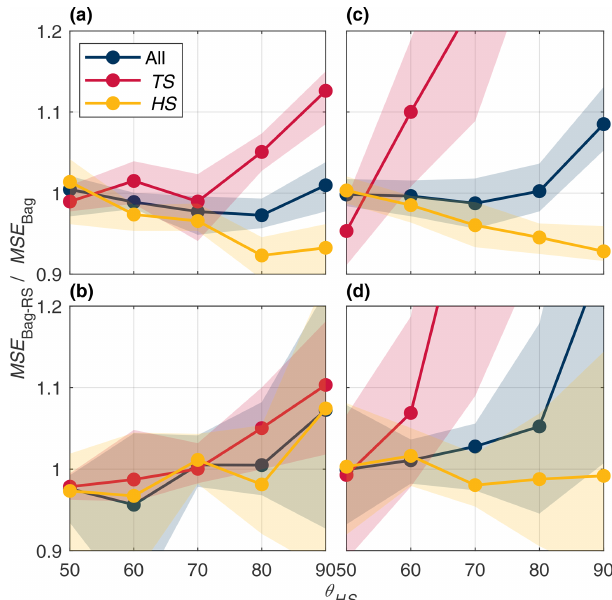
Figure 11. MSE ratio between the bagging and SMOTER-Bagging models for the Bow River calibration (a) , Bow test (c) , Don River calibration (b) , and Don test (d) partitions across high stage thresh- old values ranging from the 50th to 90th percentile stage values.